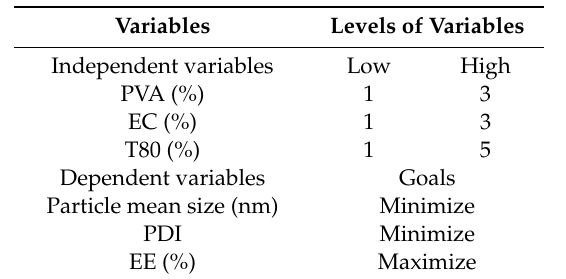
Table 2. Dependent and independent variables of Box-Behnken Design with their respective levels and